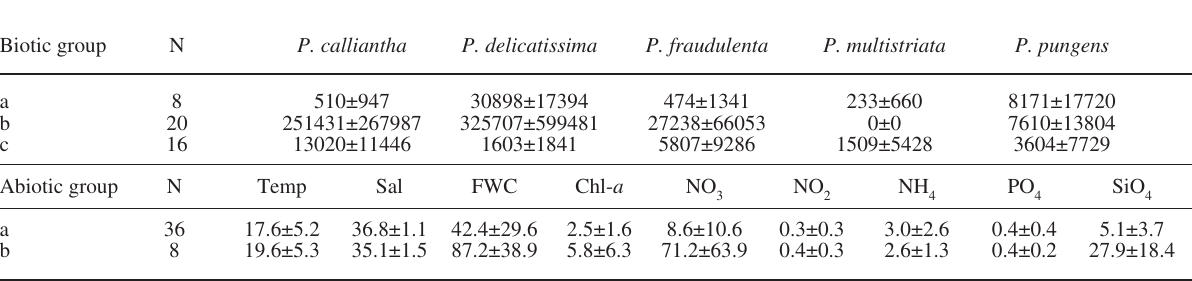
of each abiotic group.